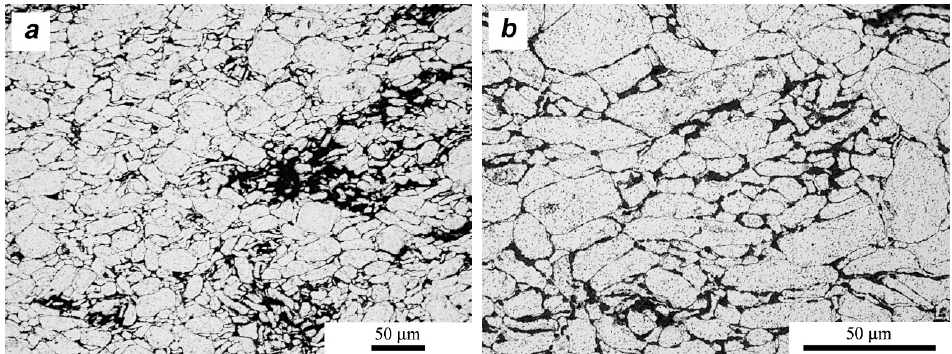
Figure 13. Microstructure of AA6061/MoS 2 10 vol % (SPS sinter). ( a ) general; ( b ) close-up view.